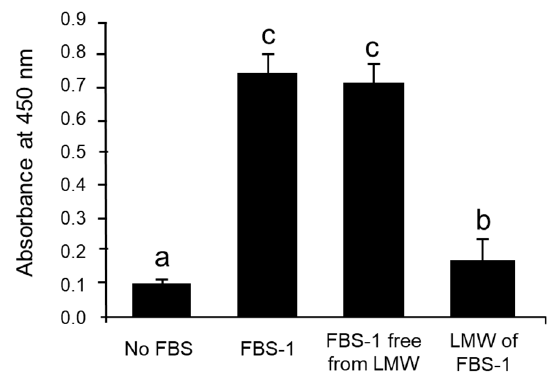
Figure 4. Effect of FBS-1 and its fractions on fibroblast growth on plastic plates. FBS-1 free from LMW, SEC Fr. 4–7; LMW of FBS-1, SEC Fr. 8–13. Data are shown as the mean ± SD ( n = 5). Different letters indicate significant differences ( p < 0.05, Tukey’s test).